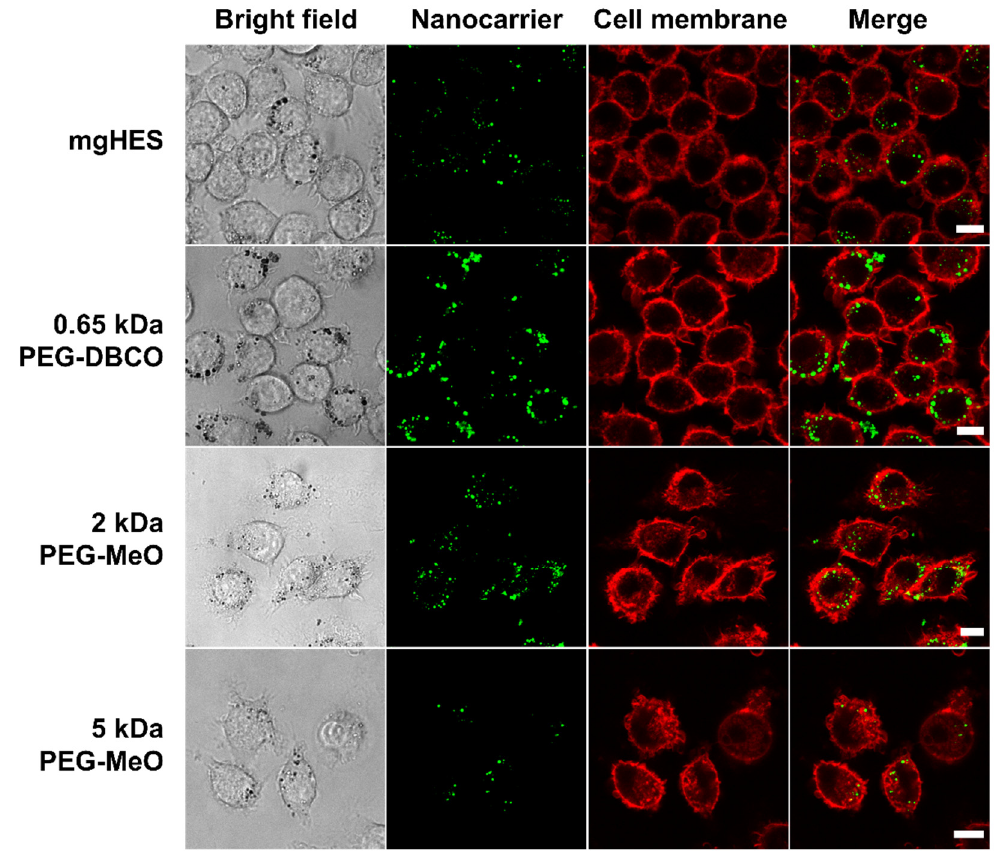
Figure 3. Longer PEG chains reduce internalization by macrophages. Mouse plasma pre-incubated nanocarriers were incubated with 5 × 10 4 RAW264.7 cells for 2 h at 37 °C with a sample concentration of 75 µg mL − 1 in DMEM medium without FBS. Live cell images are shown. All scale bars represent 10 µm.